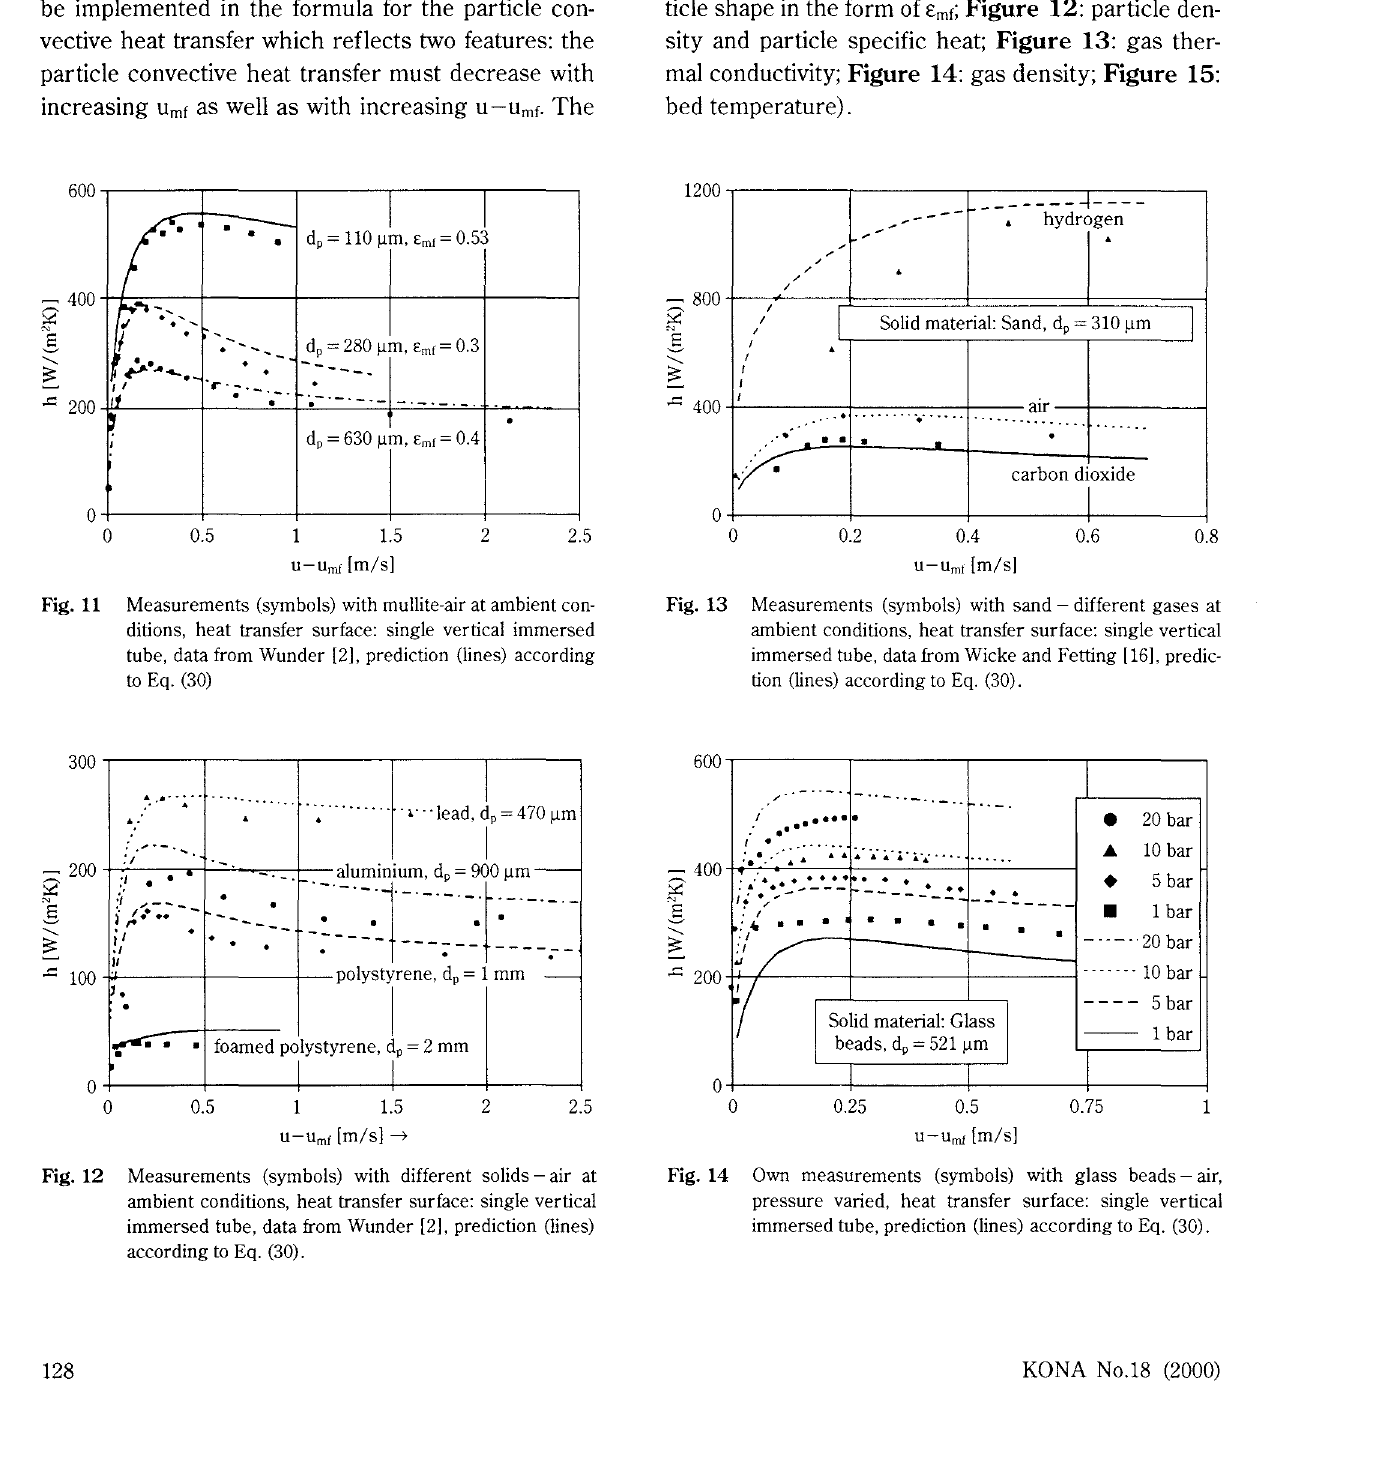
Fig. 14 Own measurements (symbols) with glass beads- air, pressure varied, heat transfer surface: single vertical immersed tube, prediction (lines) according to Eq.